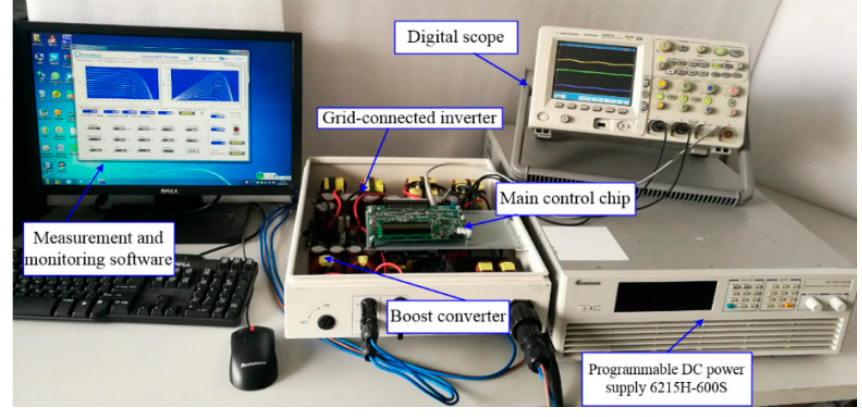
Figure 13. Experimental setup of the PV MPPT system.